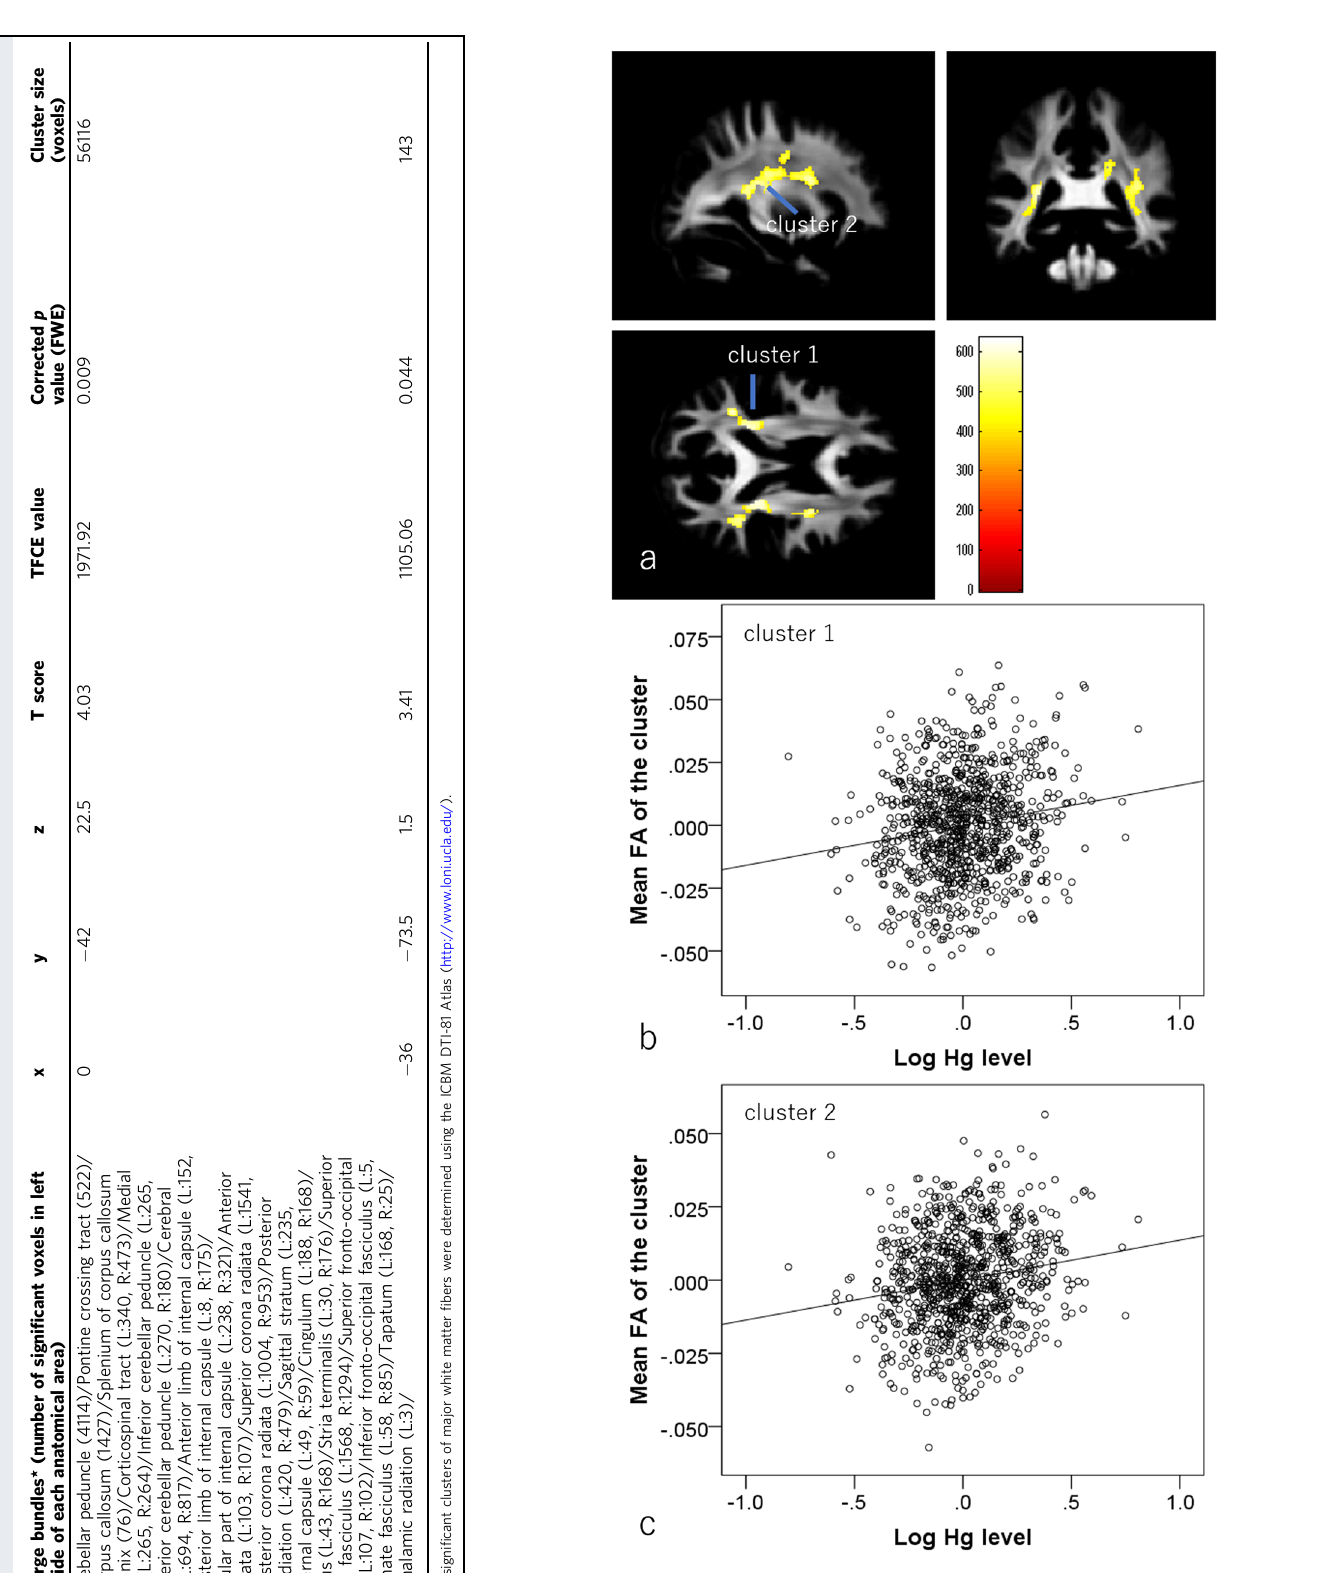
callosum and the right posterior corona radiata (Fig. 4 and Table 3). Similar to other neuroimaging metrics, the effect sizes of signi fi cant associations between hair mercury levels and mean values of signi fi cant clusters were generally weak, and absolute values of partial correlation coef fi cients were all smaller than 0.180.